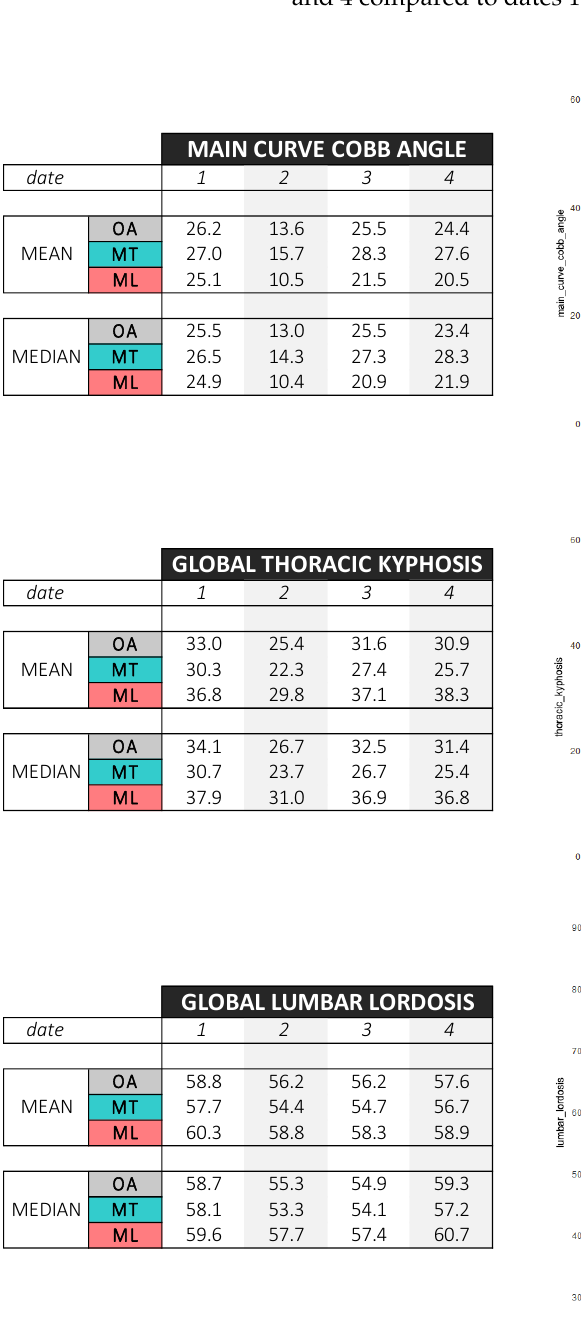
Figure 3. Descriptive repetitive EOS roentgenogram measures (mean, median and boxplots) for date 1 brace prescription day, date 2 in-brace roentgenogram, date 3 weaning and date 4 control 1 year after weaning. ( a ) concerns main curve Cobb angle, ( b ) concerns thoracic kyphosis, and ( c ) concerns lumbar lordosis.